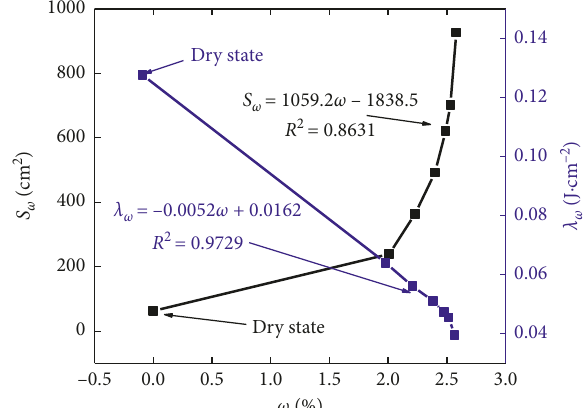
Figure 13: Variation curve of surface area and surface energy with moisture